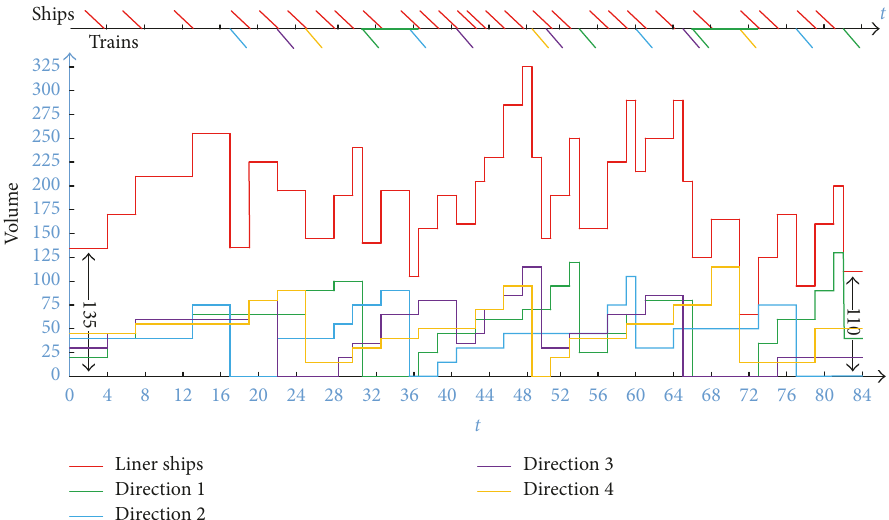
Figure 7: Transportation scheme and the volume of 15 container trains.